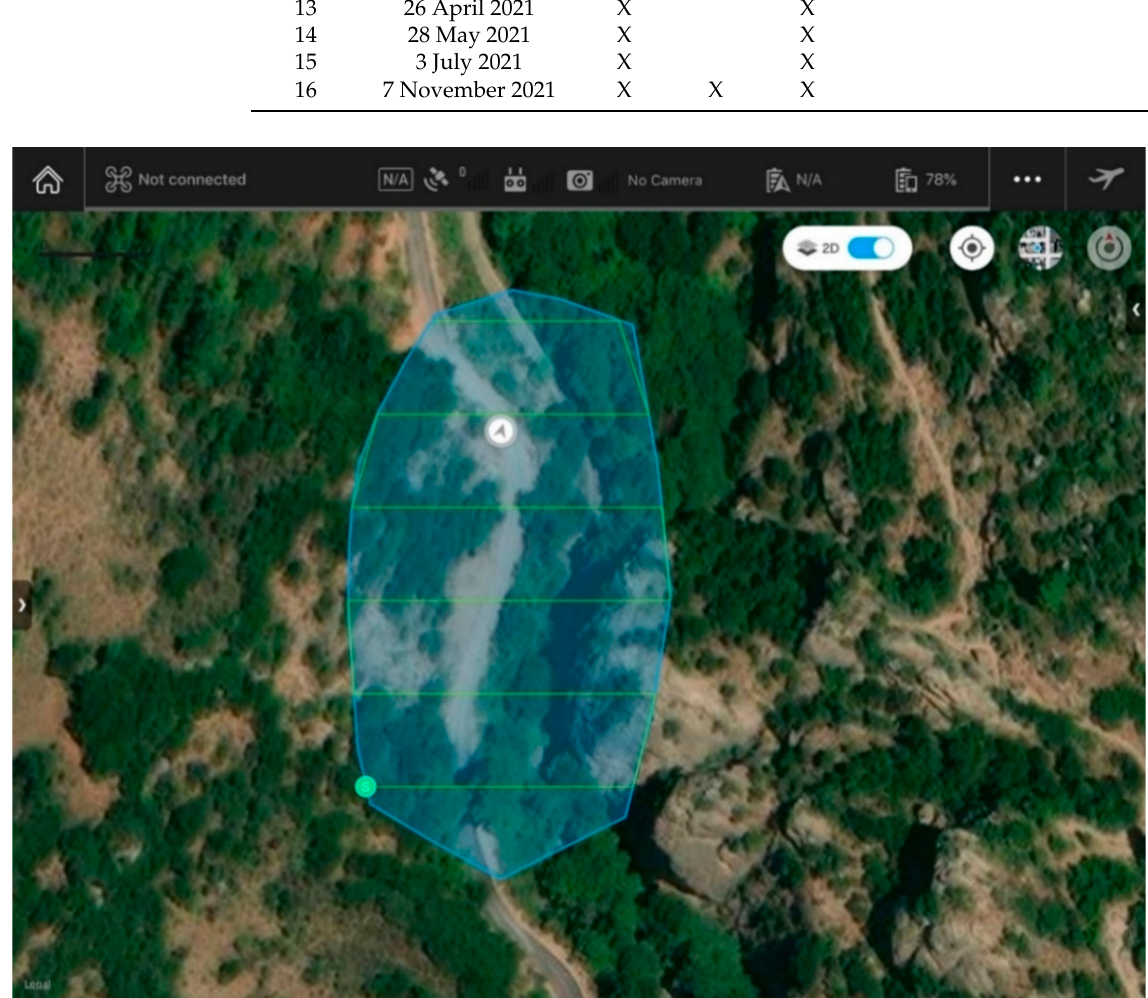
Figure 3. The flight grid of the photogrammetric UAV campaigns.